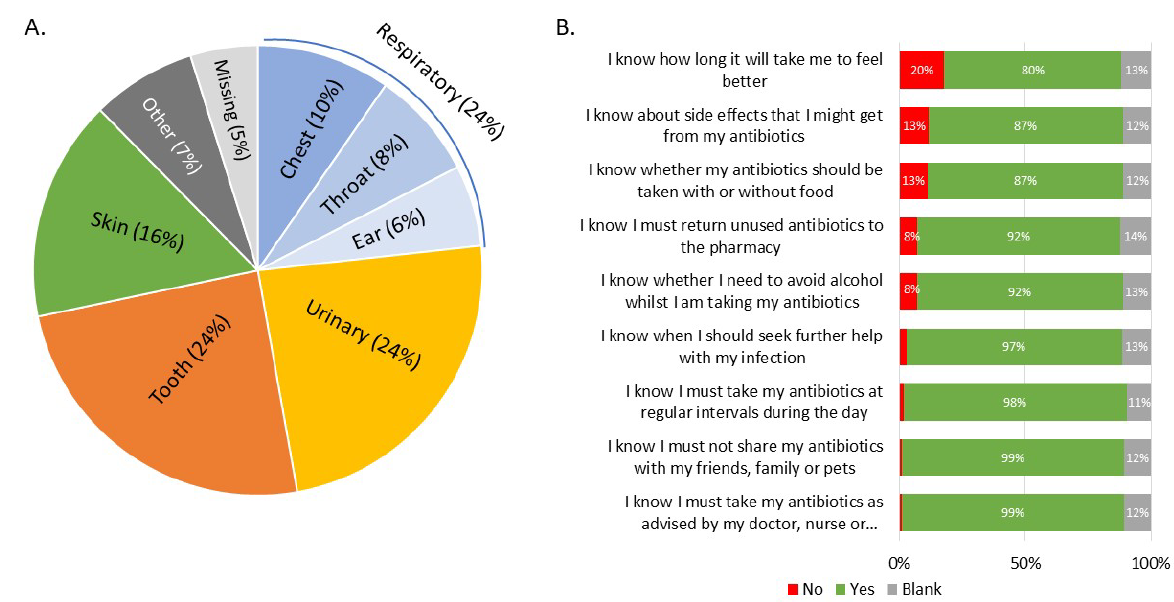
Figure 2. Patients’ ( n = 2043) infection ( A ) and self-reported knowledge of antibiotic and